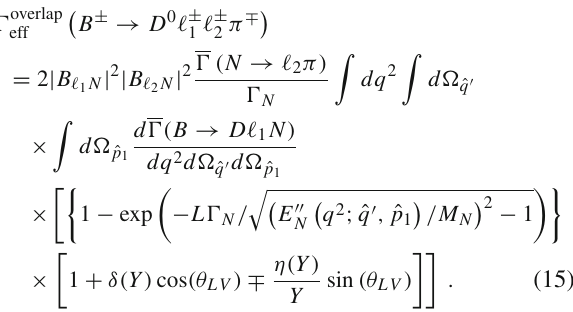
Figure8showstheCPasymmetryinEq.16asafunctionof the maximal displaced vertex length L (top) and Y parameter